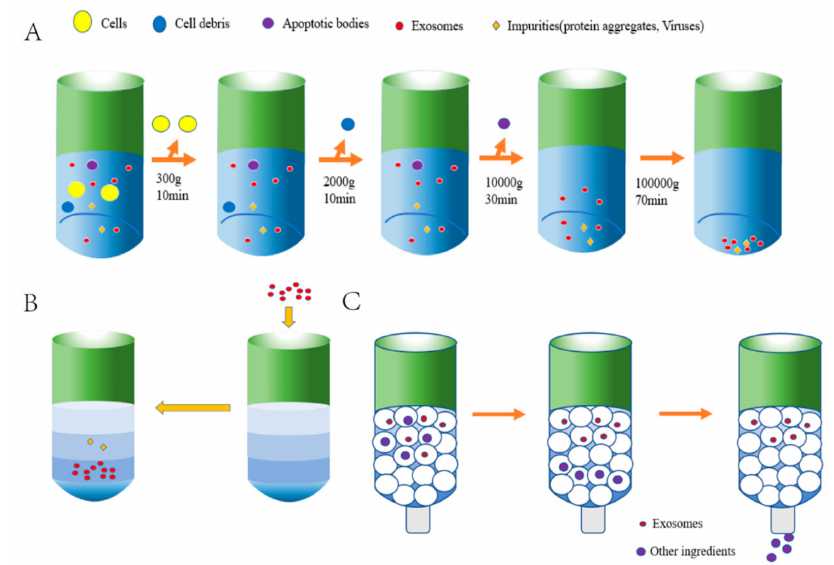
Figure 2. Exosome separation diagram. ( A ). Ultracentrifugation. First, the samples are centrifuged at 300 × g , 2000 × g, and 10,000 × g to remove larger cells, cell debris, and dead cells. Secondly, the exosomes are isolated via ultracentrifugation twice at a speed of more than 100,000 × g . ( B ). Isopycnic density gradient centrifugation. Impurities are firstly removed via low-speed centrifugation, and then, the separated samples are added to the constructed density medium (3%, 35%, 45%, and 90%) for separation. ( C ). Size-exclusion